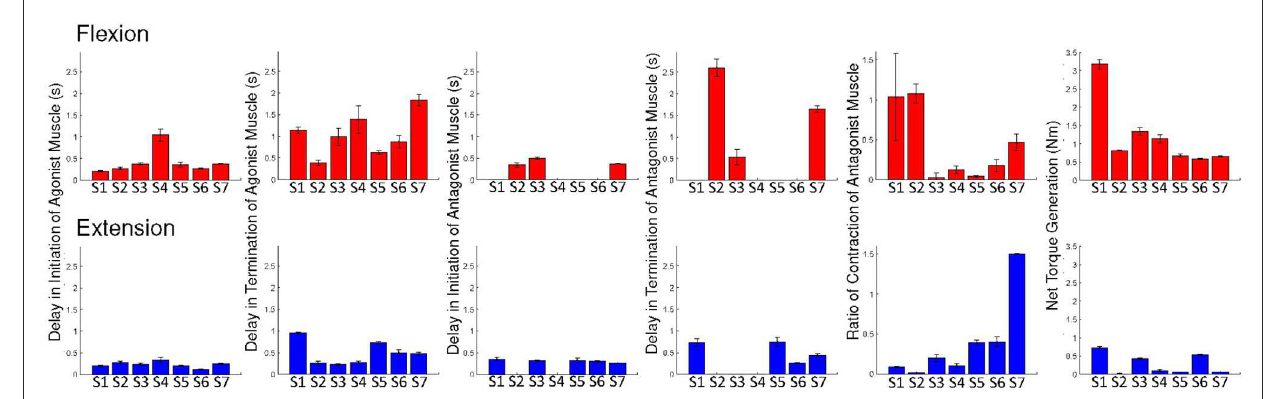
FIGURE2 Individual results: the delays of initiation and termination of the agonist muscle, delays of initiation and termination of the antagonist muscle, and ratios of antagonist muscle activation and the net torque, during voluntary flexion and extension. Error bars are ± 1 standard error of the mean.